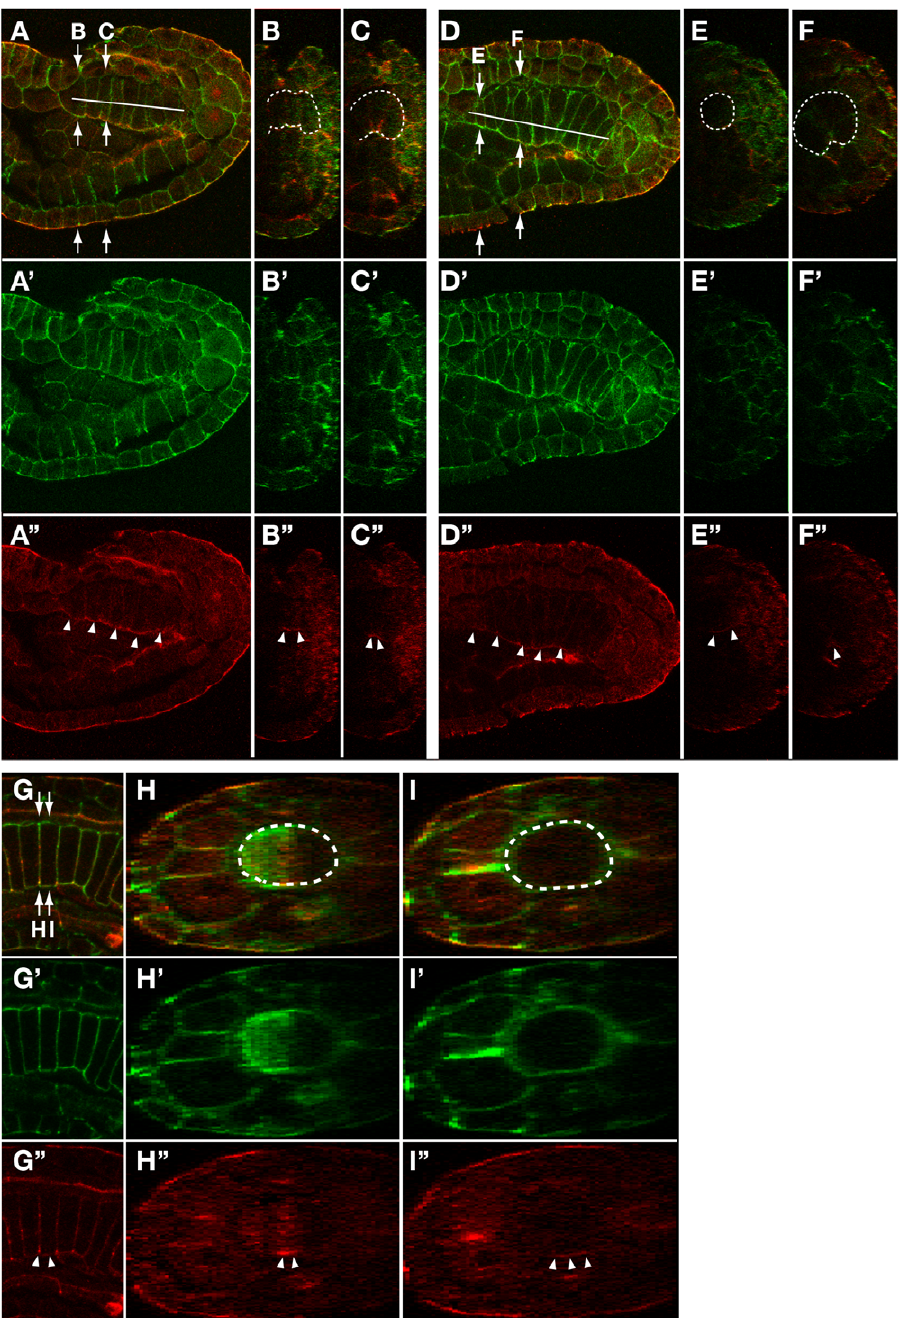
Figure 3. Accumulation of aPKC at the ventral surface of notochord cells is retained during cell intercalation process. (A,D,G) Confocal saggital section images of the notochord of a late neurula (A), early tailbud (D) and middle-late tailbud (G) stage embryos double-stained for aPKC (red) and phalloidin for actin (green). Lateral views with anterior to the left. Reconstructed cross section image at the level indicated by arrows in A, D and G is shown in B/C, E/F and H/I. Position of the notochord in saggital section and cross section images is indicated by a white line in A and D or surrounded by white dotted line in B,C,E,F,H,I. Accumulation of aPKC is indicated by white arrowheads in A’–I’. doi:10.1371/journal.pone.0013689.g003 which notochord cells establish and maintain a polarity along the along the dorsoventral axis during convergence and extension dorsoventral axis in an Eph -dependent manner restricting cell processes. Importantly, this dorsoventral distribution of cell polarity markers in notochord plate cells is diminished by a dominant-negative form of Eph, but not by that of Dishevelled, giving rise to non-polarized notochord cells that fail to undergo normal intercalation. The data are consistent with a model in